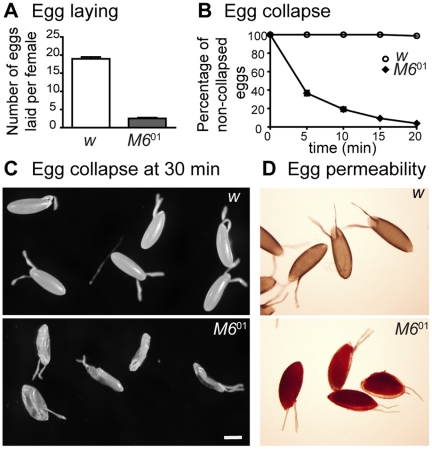
Female sterility results from eggshell malformation.(A) Egg laying was evaluated as the number of eggs laid by control and M6
01 females crossed to wild type males. Mean ± s.e.m., n = 2; Mann Whitney test, p<0.01. (B) Resistance to water loss was determined over time. Eggs laid by control and M6
01 females were collected, transferred to a dry plate and monitored over time. Collapsed eggs were quantified every five minutes for 20 minutes; the percentage of non-collapsed eggs was plotted, n = 2. (C) Representative images of control and M6
01 eggs taken 30 minutes into the time course shown in B. Scale bar is 400 µm. (D) Eggs laid by control and M6
01 females were collected and incubated with the neutral red dye. A total of 100% of M6
01 mutant eggs were permeable, indication of an abnormal vitelline membrane. Note that M6
01 eggs become unusually enlarged in aqueous solution.